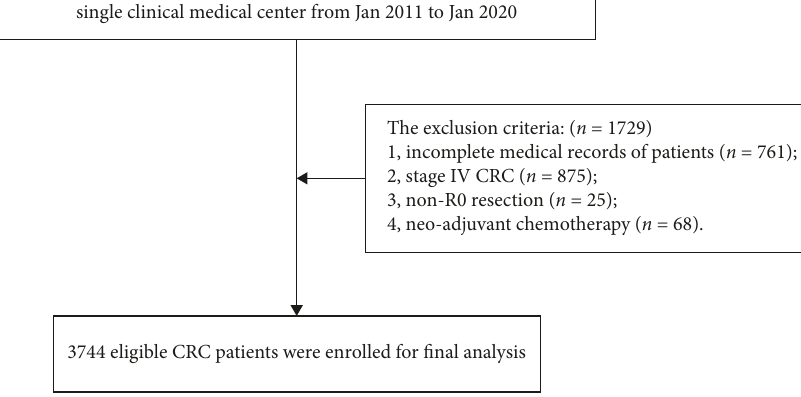
Figure 1: Flow chart of patient selection. Table 1: Baseline information of the different waiting groups.